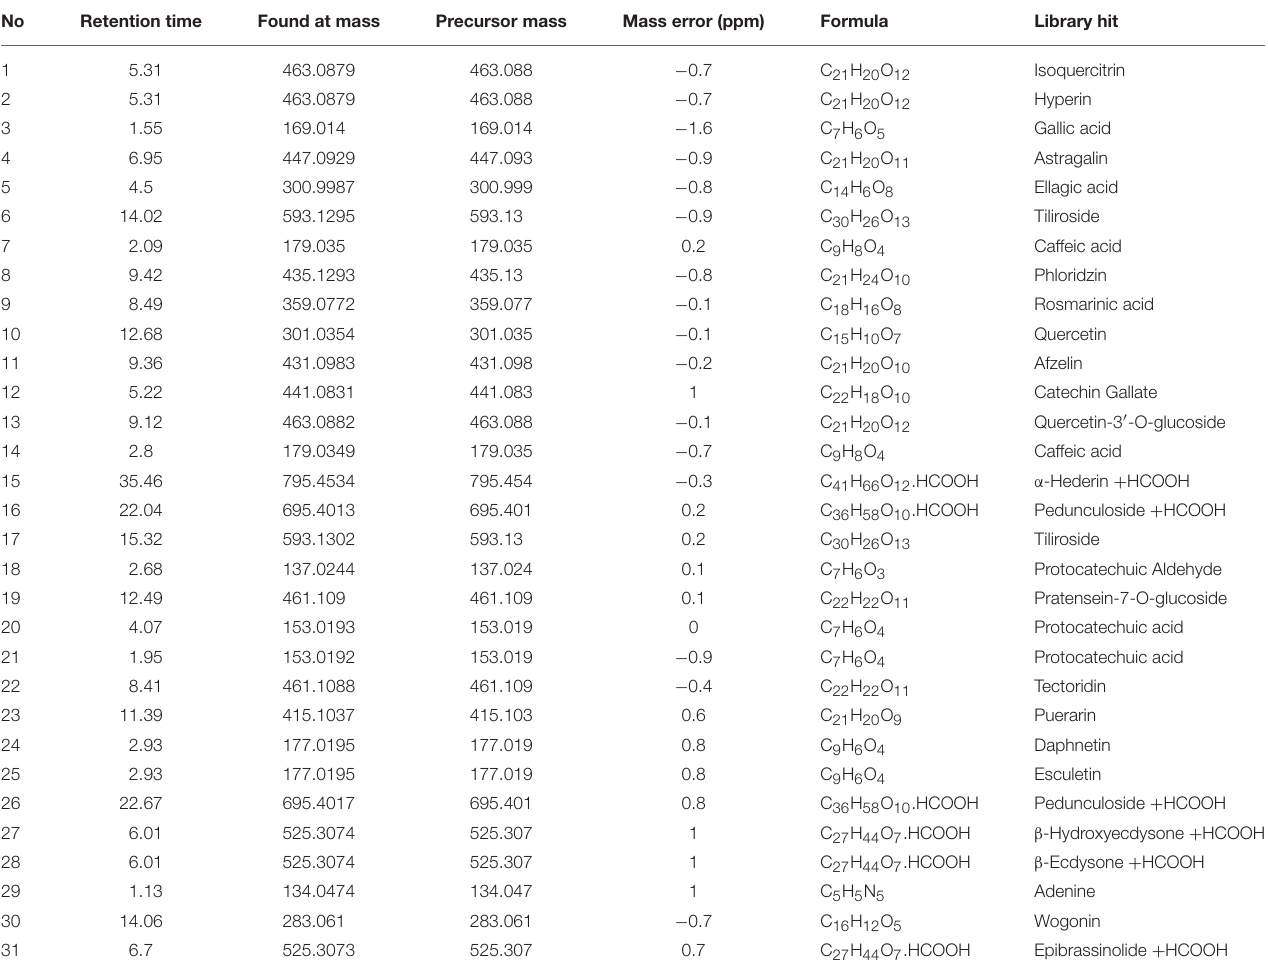
TABLE 1 | High resolution mass spectrometry data and elemental composition of PEC (Negative Ion